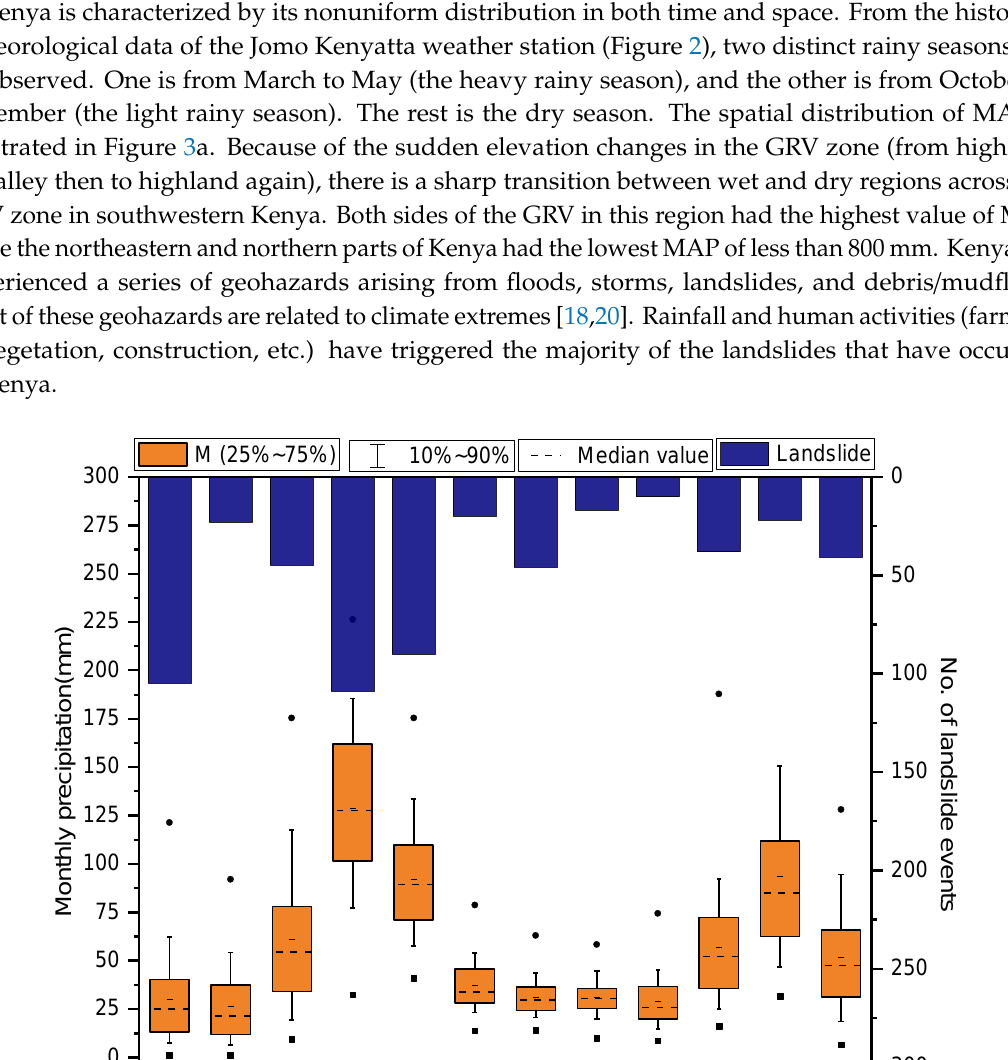
Jan. Feb. Mar. Apr. May Jun. Jul. Aug. Sep. Oct. Nov. Figure 2. Statistics of monthly average precipitation and distribution of landslides in Kenya. Precipitation data was obtained from the Jomo Kenyatta weather station. Since no detailed information of the exact occurring moth of landslides in LS3, only LS1 and LS2 data were included in this figure.